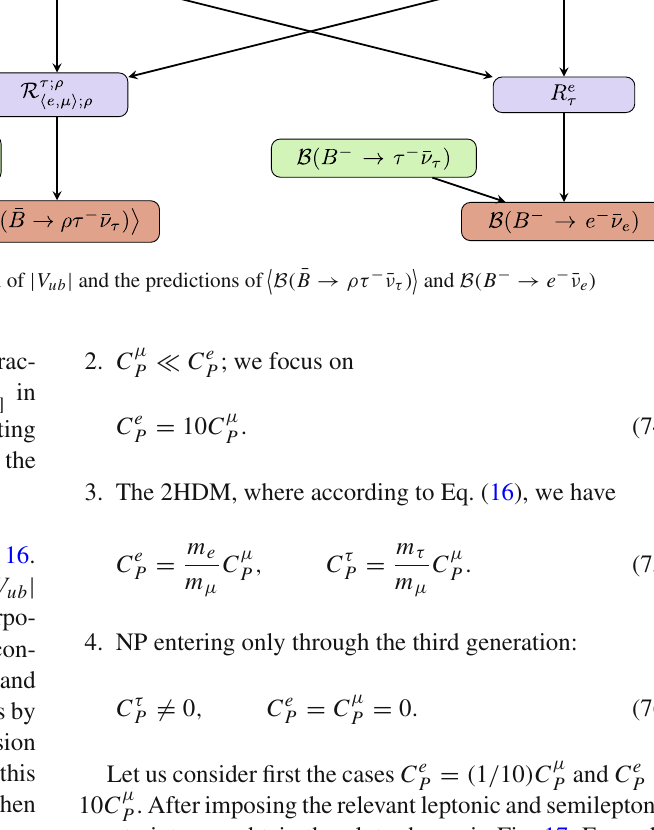
Fig. 16 Flowchart illustrating the strategies for the determination of | V ub | and the predictions of